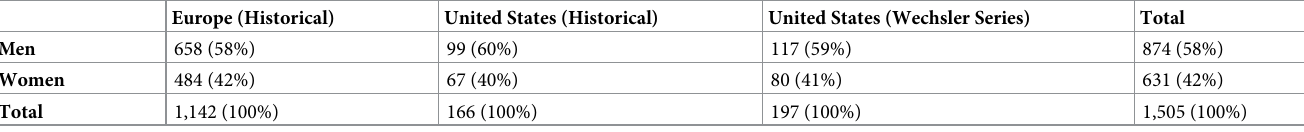
Table 5. Sex distribution of multiple sclerosis cases reported prior to 1922 �